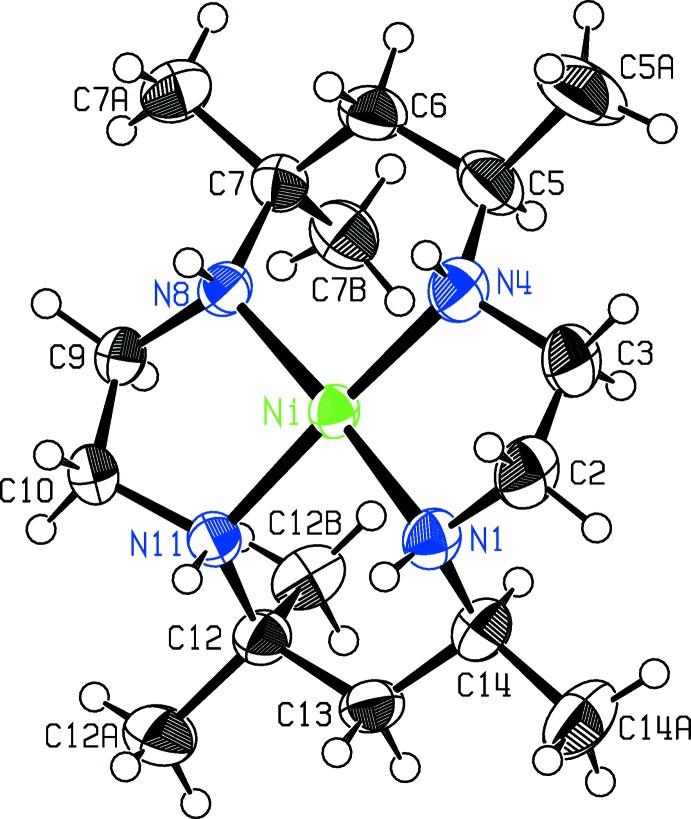
The [Nime6cyclam]2+cation in the macrocycle bromide salt II. Displacement ellipsoids are at the 50% probability level.